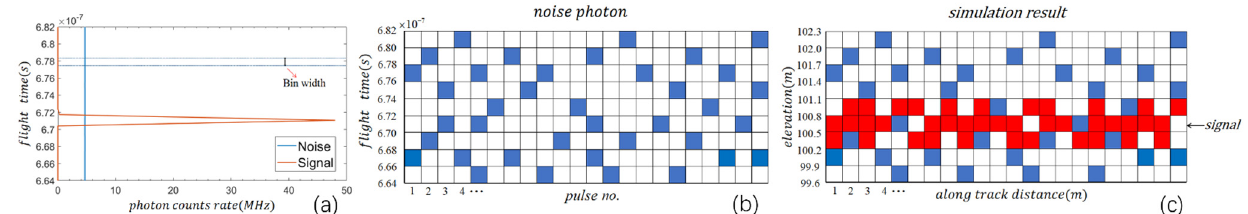
Figure 2. Schematic diagram of simulation signal generation process. ( a ) Schematic diagram of signal and noise photon count rate as a function of flight altitude. ( b ) Schematic diagram of the noise photon corresponding to each pulse—the blue points are noise photons. ( c ) Simulation of the two-dimensional profile diagram, where the blue points are noise photons and the red points are signal photons.